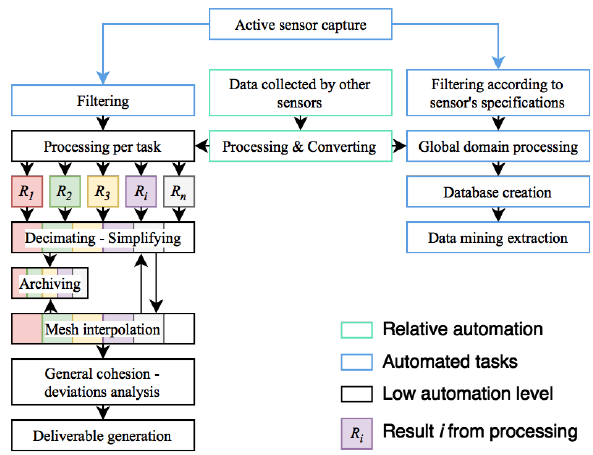
Figure 1 Common TLS workflow vs smart